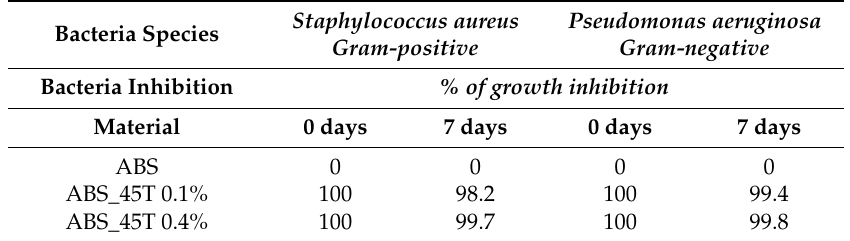
Table 2. Antimicrobial efficacy of polymer composites before and after 7-day polymer incubation in DMEM medium containing 10% FBS.